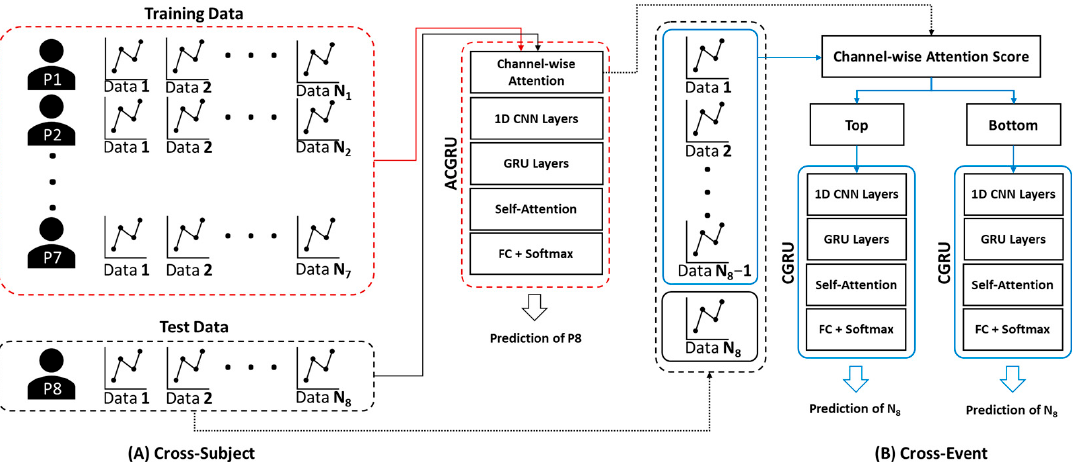
Figure 3. The method for cross-validation of ( A ) ACGRU and ( B ) CGRU models. ( A ) The ACGRU models aimed to classify preictal seizures using a between-subject experiment, which trained with seven patients and tested with the remaining one patient. The process was repeated eight times by permuting the test data. ( B ) The CGRU models were retrained with the top or the bottom three (or six) channels selected based on the attention score of each individual patient from the pretrained ACGRU model. The N − 1 preictal data were adopted for training and the remaining one preictal data were used as the test data when N seizures were detected in a patient. The process was repeated N times by permuting the test data.